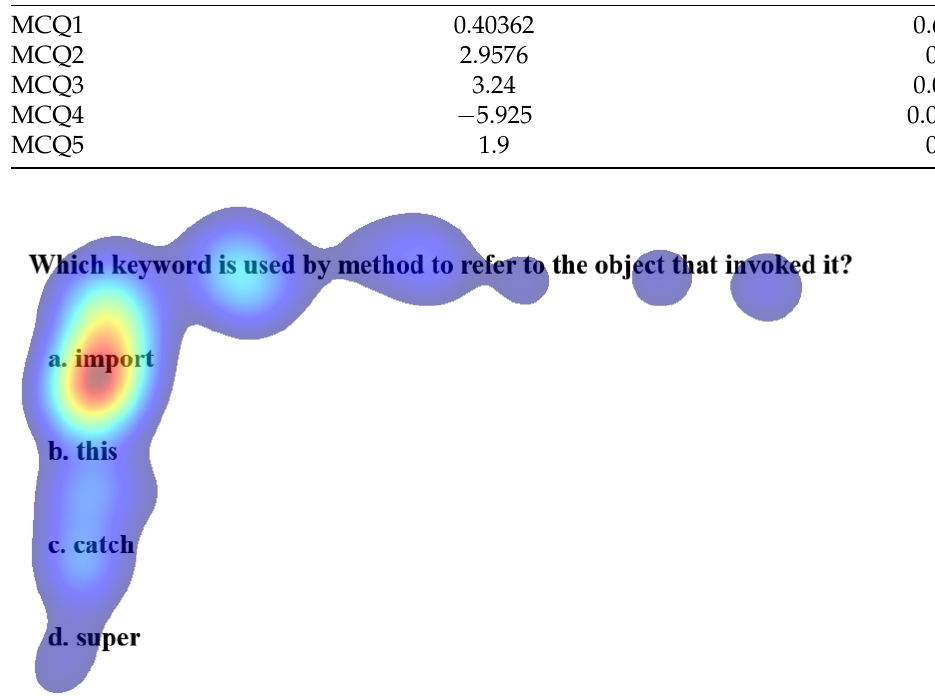
Figure 7. Heatmap of learner S6 on MCQ1 representing Inattentional Blindness.